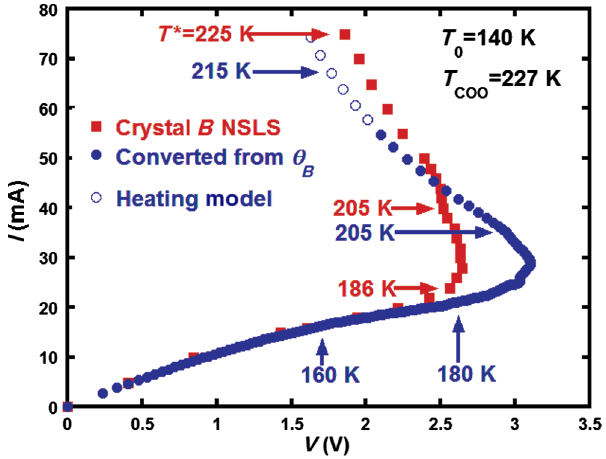
FIG. 7. The full widths of the half maximum of the COO satellite reflections ( 1 = 4 , 1 = 4 , 12) determined as a function of current and plotted against the same T (cid:3) values used and explained in the caption of Fig. 6. The highest current is 80 mA, so that the vertical part of the I ð V Þ is included. The inset displays some COO peaks for T (cid:3) ¼ 140 , 159, 182, and 201 K. For clarity of display, 2 θ of the peak for T (cid:3) ¼ 159 , 182, and 201 K are shifted to be aligned with that of T (cid:3) ¼ 140